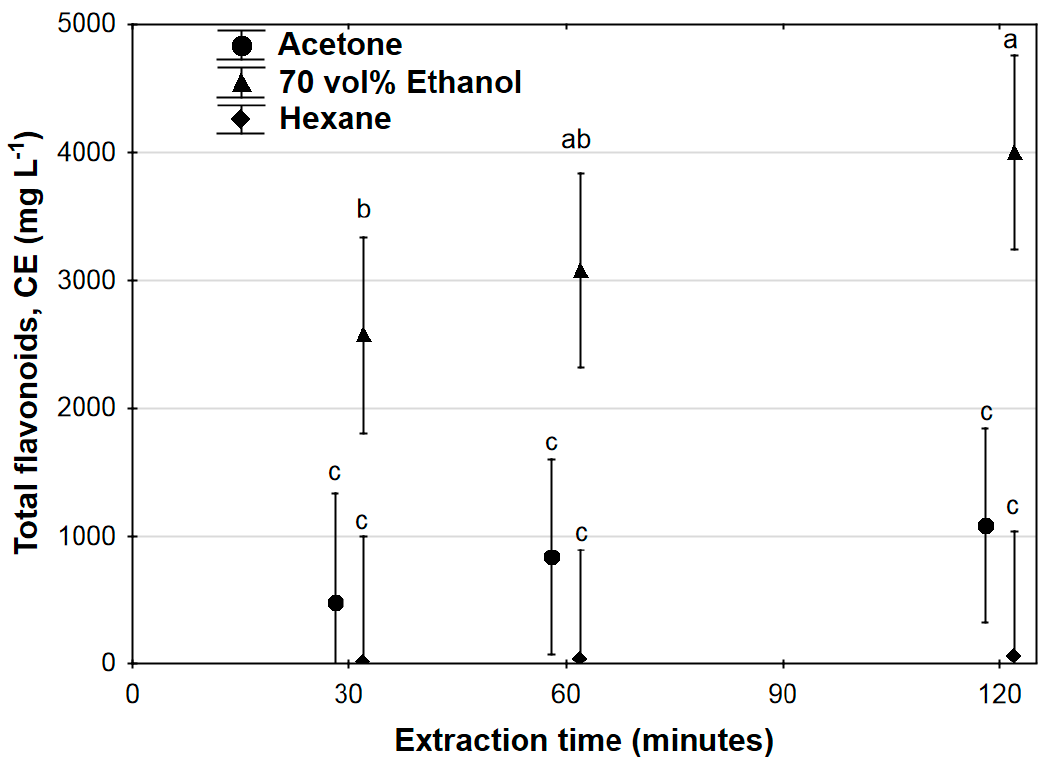
Figure 2. Total flavonoid content of Ximenia caffra extracts over time, expressed as catechin equivalents (CE). Data are represented as mean ± 95% confidence intervals. Values with common superscripts do not differ significantly.